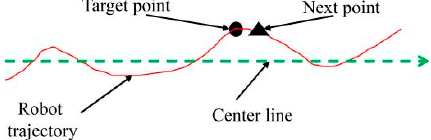
Figure 13. Schematic diagram of yaw angle measurement.